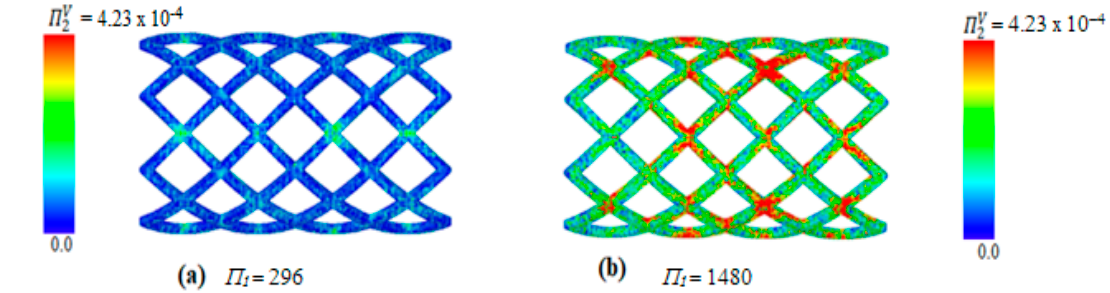
Figure 3. Local Π V 2 at ( a ) Π 1 = 296, and ( b ) Π 1 = 1480.